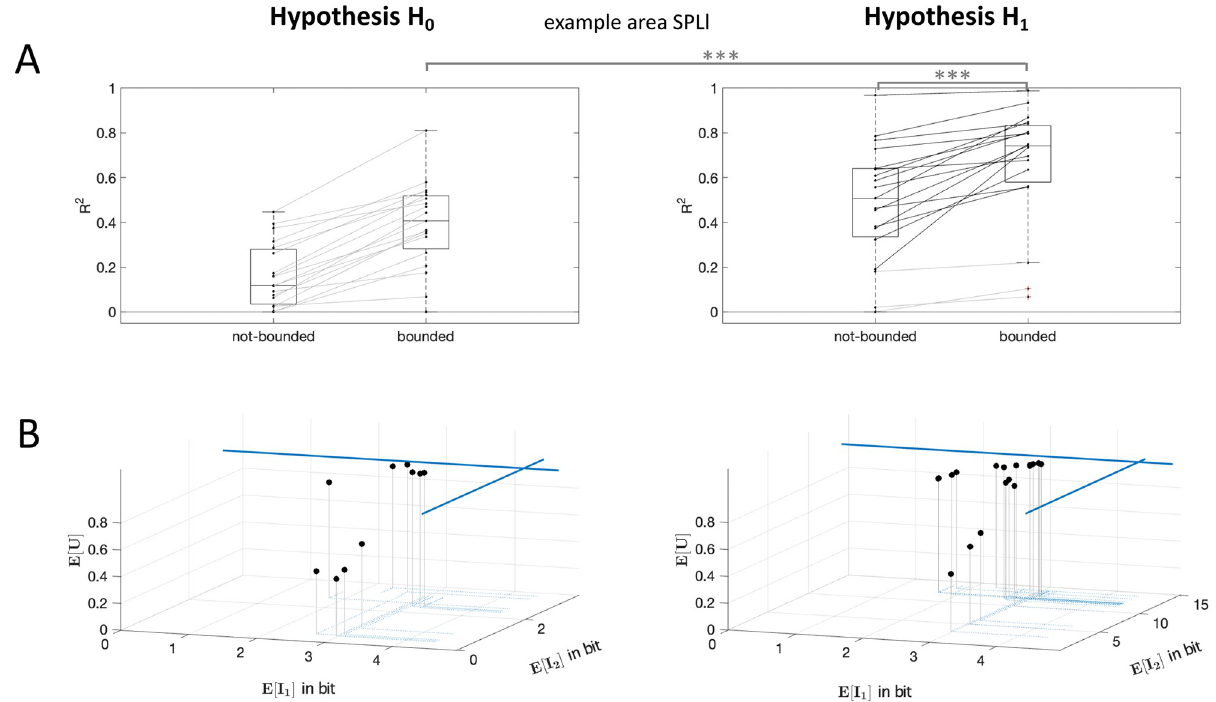
Fig 5. H 0 and H 1 model comparison. (A) R 2 -values of the regressions for the best fitting information capacities for individual subjects for H 0 and H 1 are compared to not-bounded models. Statistical results of rmANOVAs are indicated with ��� for p < = 0.001. (B) Resulting theoretical quantitative predictions of the expected information costs and expected utility over all task conditions are plotted for individual subjects. Expected values of information costs E ½ I � and E ½ I � of subjects’ bounded model fits to the fMRI correlates was lower than for not-bounded model (blue lines). This hints 1 2 at prospective planning activity with subject-individual planning capacities.